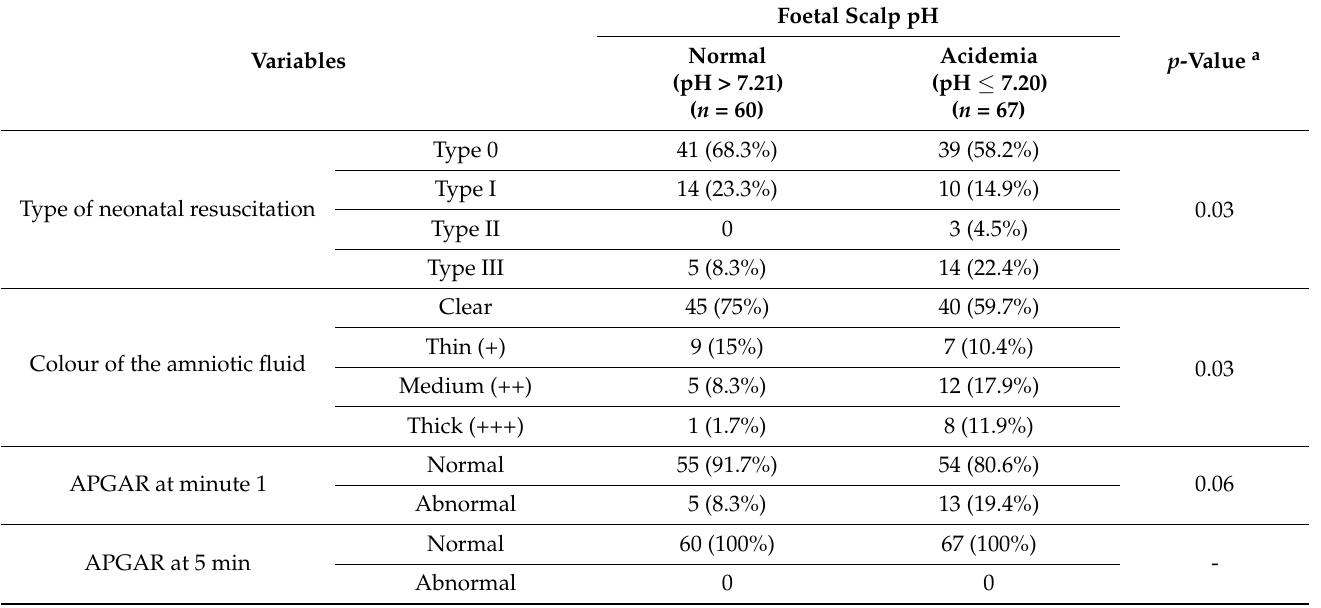
Table 1. Risk indicators of loss of foetal